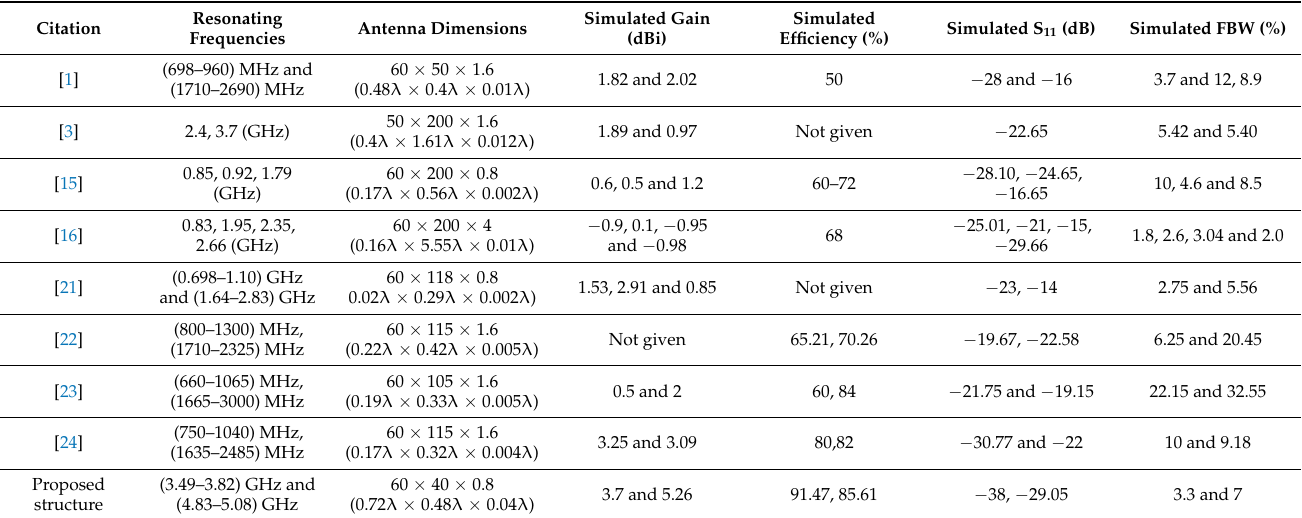
Table 2. Comparison of proposed monopole antenna with other similar